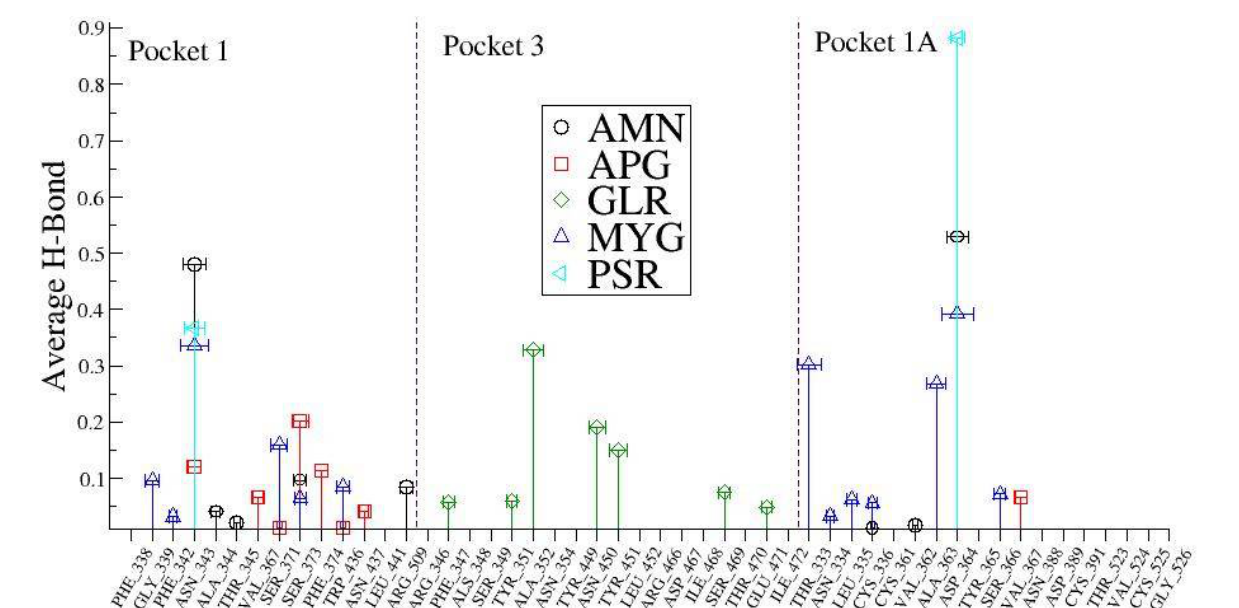
Figure 10. The average number of hydrogen bonds (standard deviation) between the drugs and SARS-CoV-2 spike protein receptor binding domain RBD.